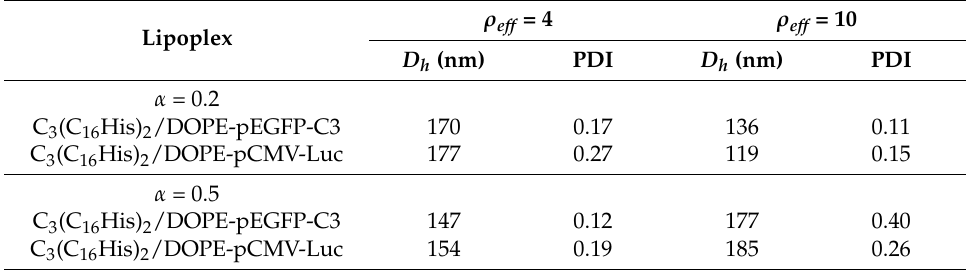
Errors are less than 10%.